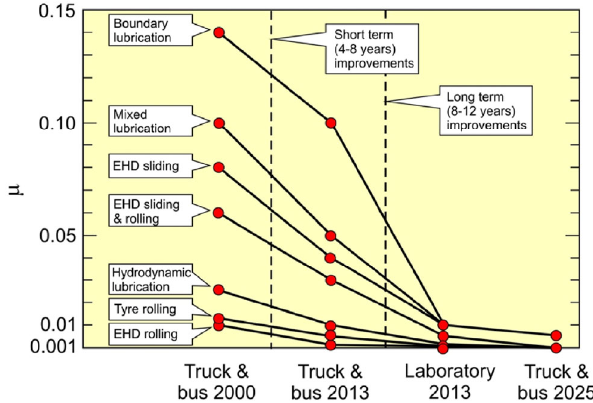
Fig. 9 Trends in the reduction of the coefficient of friction in trucks and buses for different lubrication mechanisms and for rolling friction [19].